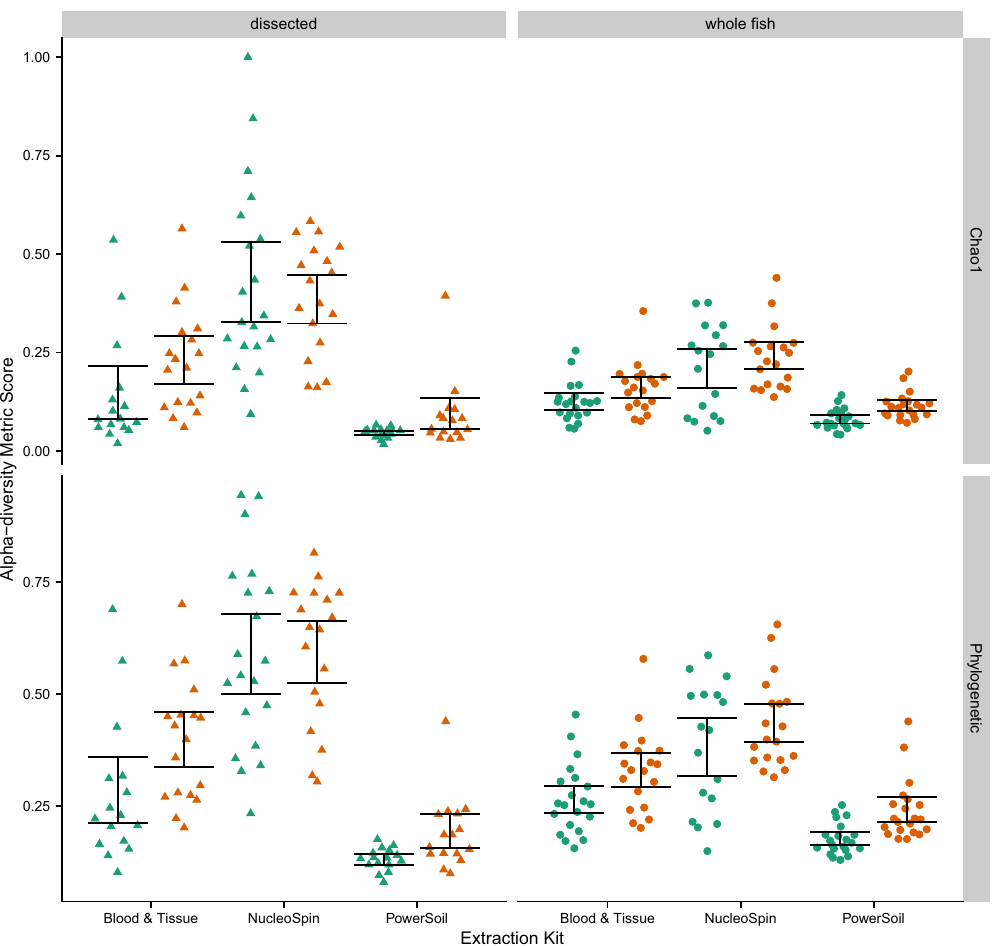
Figure 2. Swarm plots of Chao1 and Phylogenetic alpha-diversity metrics by dissection method and DNA extraction kit. The color of the point indicates BaP treatment (unexposed control vs. exposed). The black error bars indicate bootstrapped 95% C.I.s of the